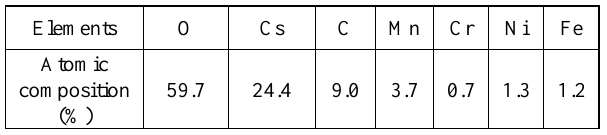
Table I: XPS surface composition after revaporization at